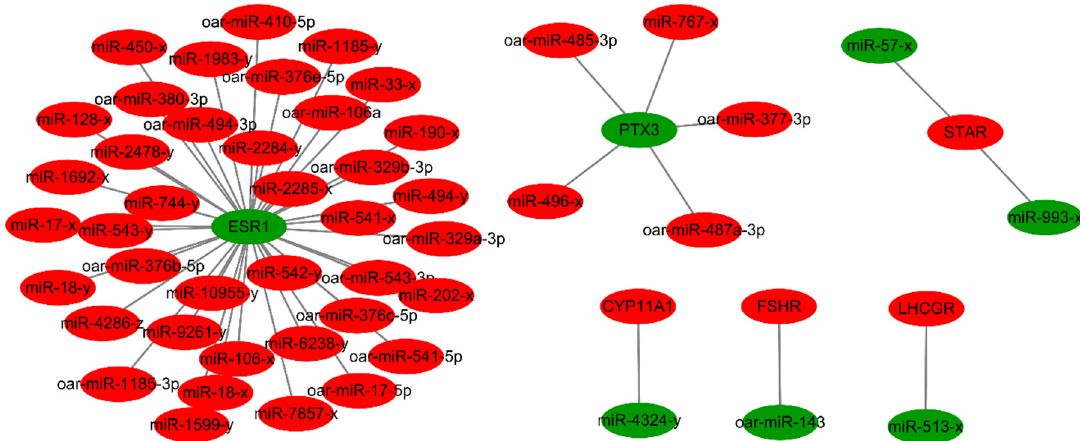
Figure 3. miRNA–mRNA expression regulatory network related to genes associated with the hormone receptor, steroid hormone secretion, and oocyte quality. Molecules in red and green denote upregulation and downregulation in the lamb libraries, respectively.